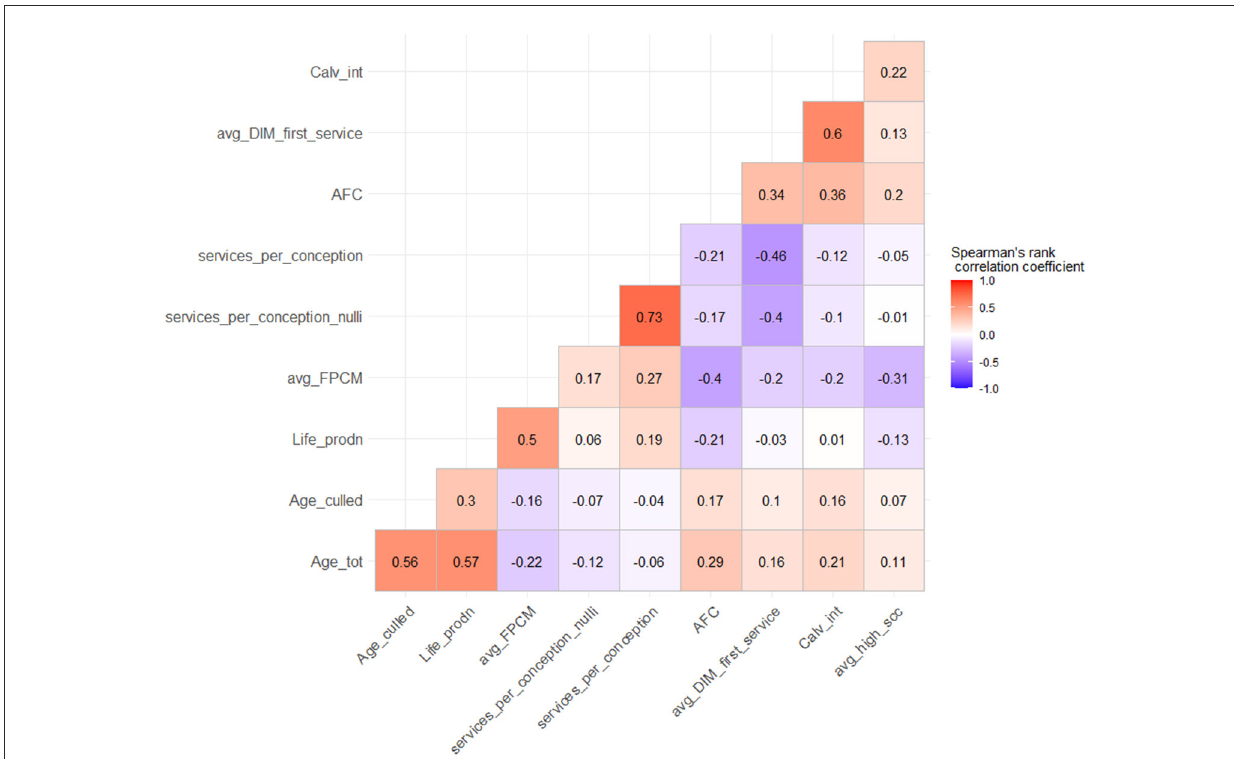
FIGURE3 Spearman’s rank-correlation matrix (lower triangle) of performance indicators. The variables in rows and columns are the 10 performance indicators in four areas. Age_tot, total herd average age; Age_culled, herd average age of culled cows; Life_prodn, lifetime production of milk; Avg_FPCM, herd average daily fat-protein corrected milk; services_per_conception_nulli, mean number of inseminations per calf (in nulliparous cows); services_per_conception, mean number of inseminations per calf (in multiparous cows); AFC, age at first calving; avg_DIM_first_service, interval of days in milk (DIM) between last calving and first insemination; Calv_int, herd average calving interval; avg_high_scc, proportion of cows in herd with high somatic cell count. Diagonal (self-correlations) not